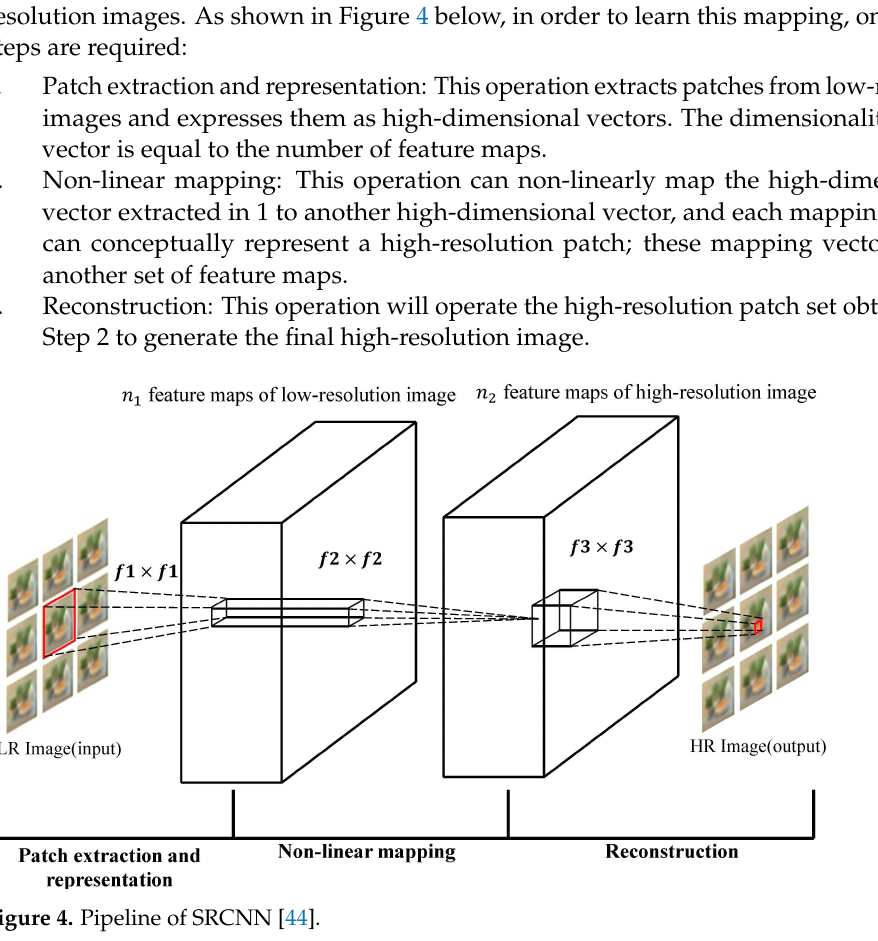
Figure 4. Pipeline of SRCNN